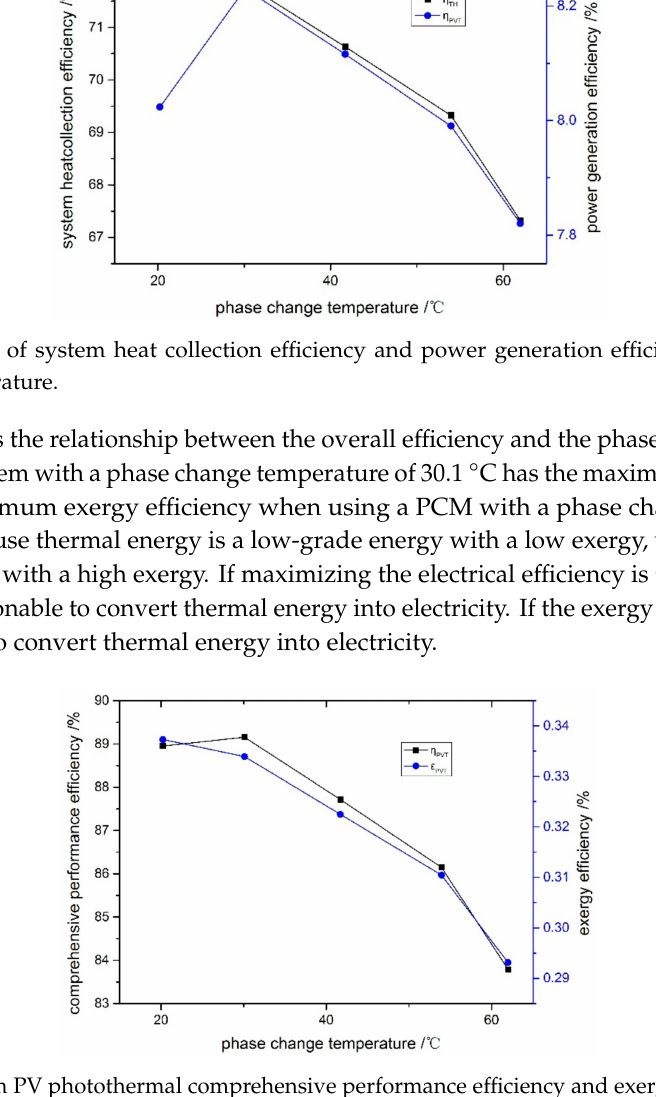
Figure 10. System PV photothermal comprehensive performance e ffi ciency and exergy e ffi ciency with phase transition